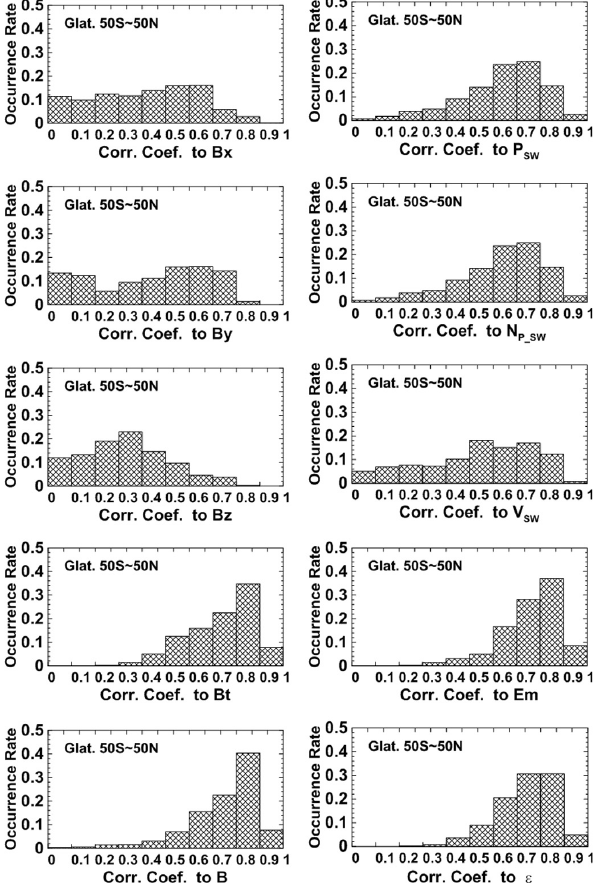
Fig. 5. Distribution of correlation coefficient of the storm-time den- sity changes with various interplanetary parameters at mid- and low latitudes for all local time sectors taking all the 35 storms into ac- count in statistics.